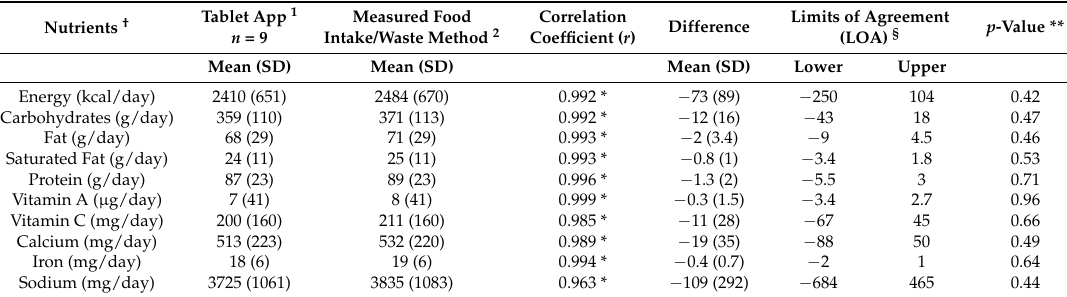
Table 2. Daily energy and nutrient intakes recorded by Canadian Armed Forces (CAF)